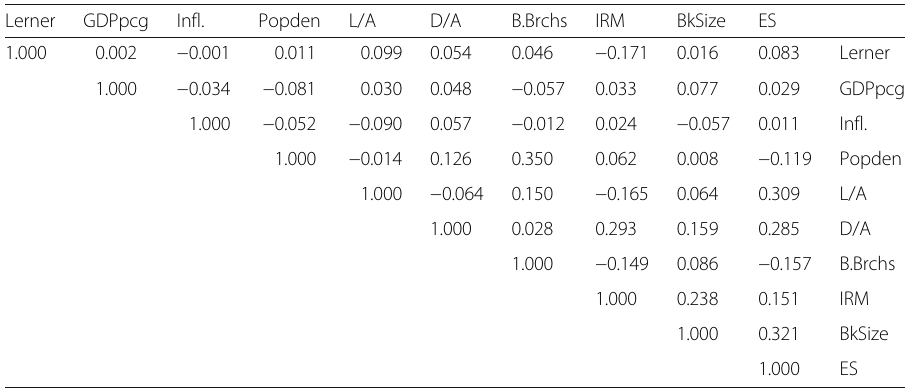
Table 4 Correlation matrix Lerner